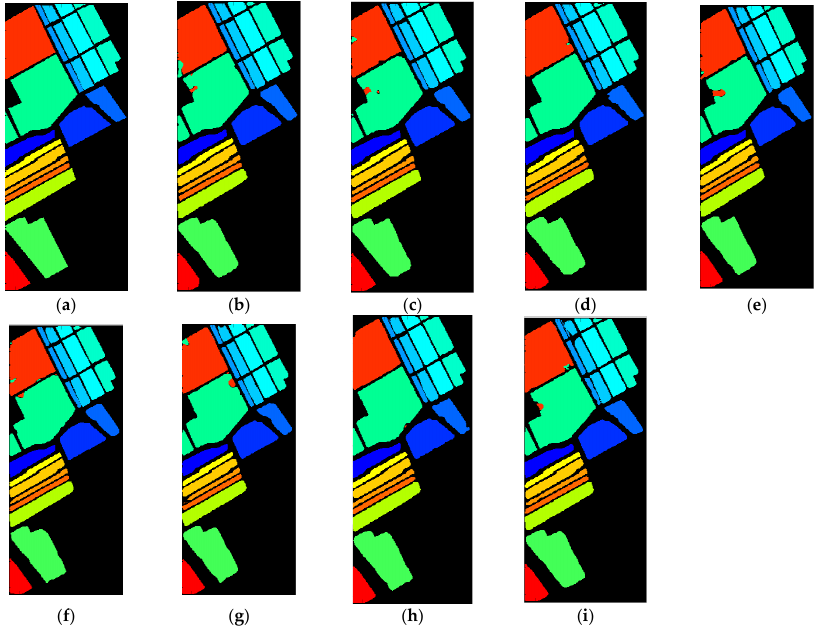
Figure 5. Classification maps produced by ILCMV for Salinas using bands selected in Table 2. ( a ) Ground truth, ( b ) Full bands, ( c ) UBS, ( d ) MEAC, ( e ) MDPP, ( f ) DSEBS, ( g ) SQ LCMV-BSS-1, ( h ) SQ LCMV-BSS-2, ( i ) SC LCMV-BSS.